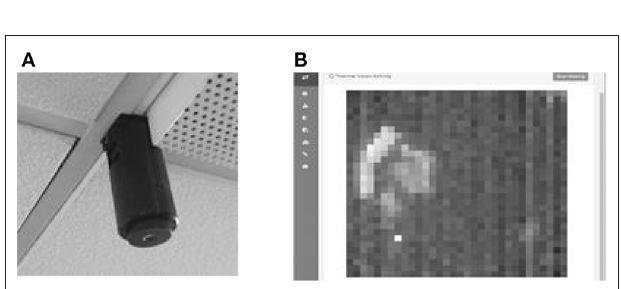
FIGURE 3 | (A) Example of prototype thermal sensor attached to the ceiling. (B) Example of a matrix generated from data collected from the thermal sensor.